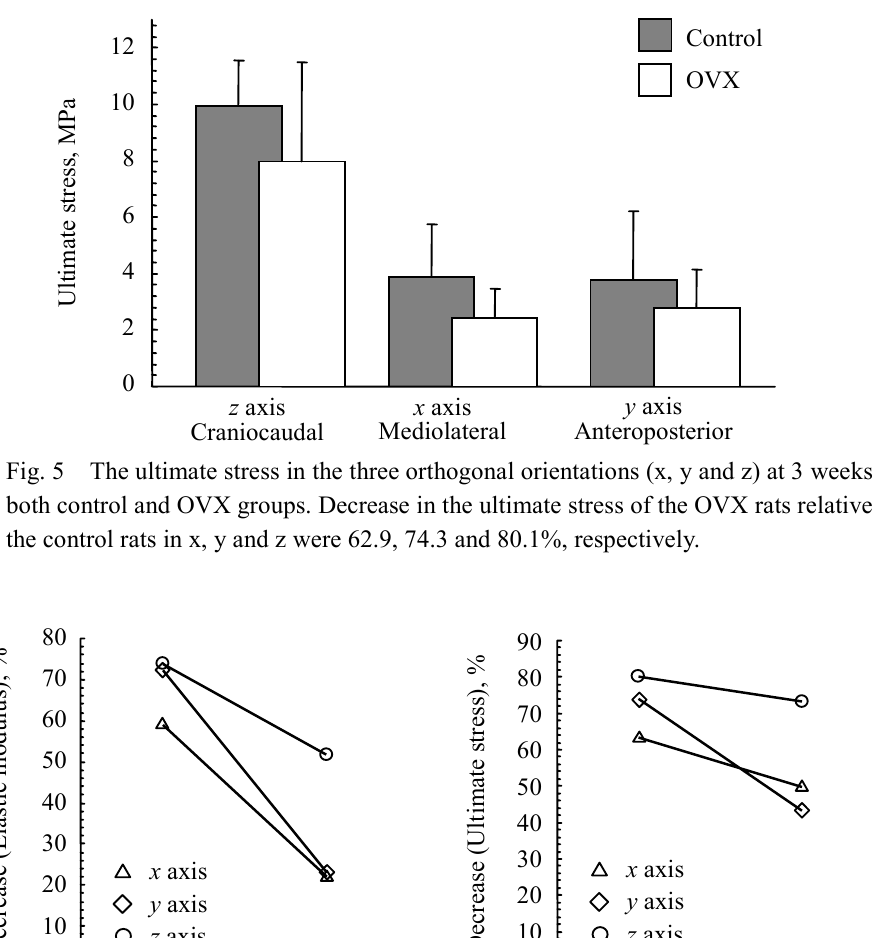
y axis z axis Craniocaudal Fig. 4 The elastic modulus in the three orthogonal orientations (x, y and z) at 3 weeks in both control and OVX groups. Decrease in the elastic modulus of the OVX rats relative to the control rats in x, y and z were 58.8, 77.2 and 73.9%, respectively.